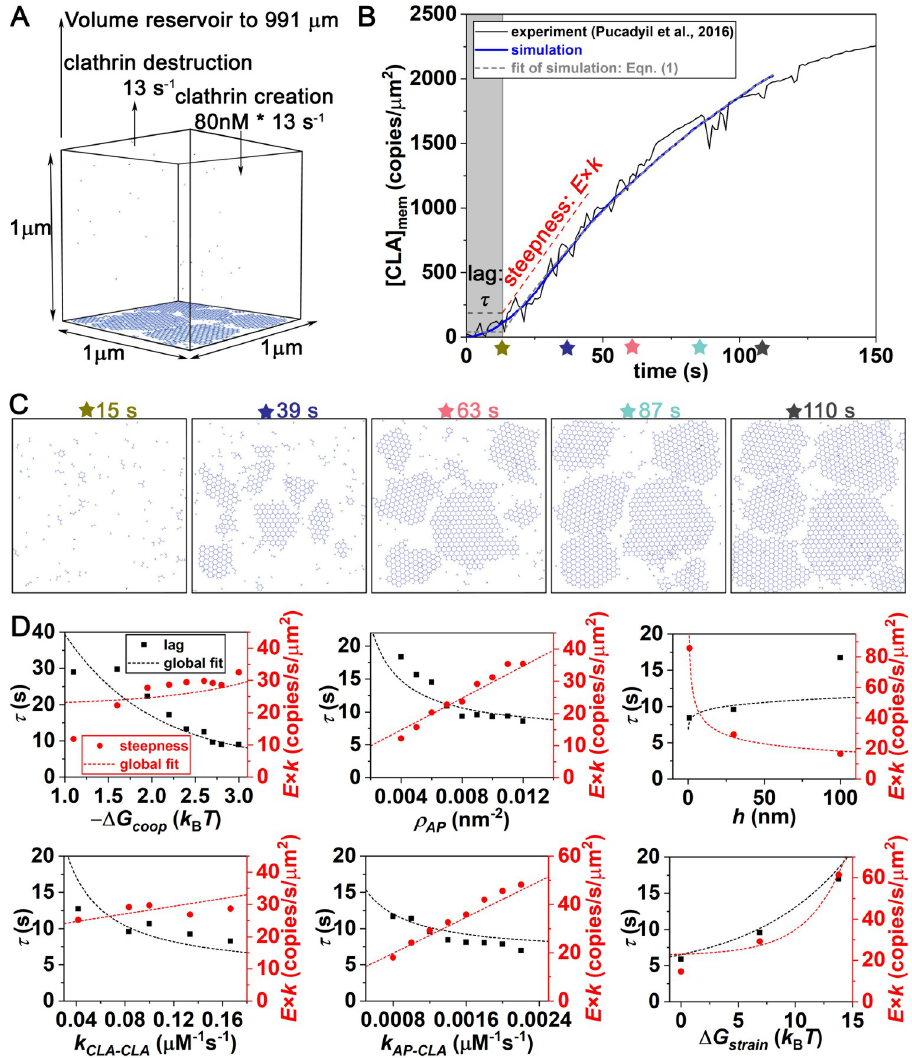
Fig 3. Structure-resolved reaction-diffusion simulations of clathrin assembly kinetics on membranes reproduce in vitro experiment. (A) Simulations were set up to mimic experimental conditions from published work of Pucadyil et al [25], where fluorescence of clathrin accumulating on membrane tubules was measured with time. A constant (fluctuating) solution concentration of clathrin (at 80nM) was maintained through exchange with a large volume reservoir. (B) Fluorescence of clathrin on membranes is averaged over multiple tubules (black line). The experimental fluorescence data was reported in arbitrary units [25]. This means there is a free scale factor we use to match with our simulations, which measure clathrin accumulation in units of copy numbers per μ m 2 . The model result is shown in blue (averaged from 4 simulation trajectories). Both the simulation data (gray dashed line) and experimental data can be fit to Eq 1A, producing timescales (growth rate k and lag time τ ) that can be directly compared to one another. The initial growth is approximately linear, with a steepness given by kE , with E the maximal extent of clathrin on the membrane (Eq 1B). (C) Snapshots of one simulation trajectory at different time points, also see S1 Movie. (D) The macroscopic timescales of the lag time τ (black dots) and initial growth steepness kE (red dots) vary with changes to six model parameters, as shown in each sub-plot D 1 -D 6 and listed in Table 1. We plot the initial growth steepness kE rather than the growth rate k , as it was more amenable to theoretical predictions. The dashed black and red lines are the theoretical fits from our phenomenological models to τ (Eq 2) and kE (Eq 3). For each subplot, the non-varied parameters are otherwise fixed to the optimal values of Table 1.